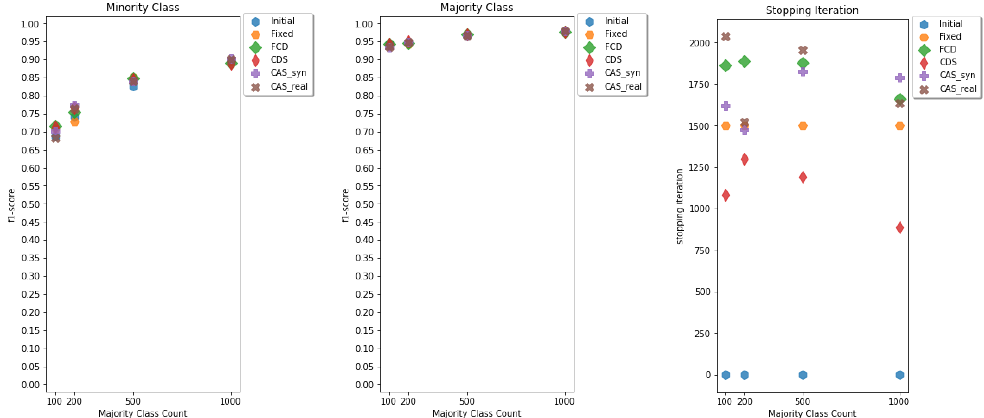
Figure 13. Average F1 results of iscx_defacement-based datasets by majority class count for mi- nority ( left ) and majority ( center ) classes, and average number of iterations until the training is stopped ( right ).